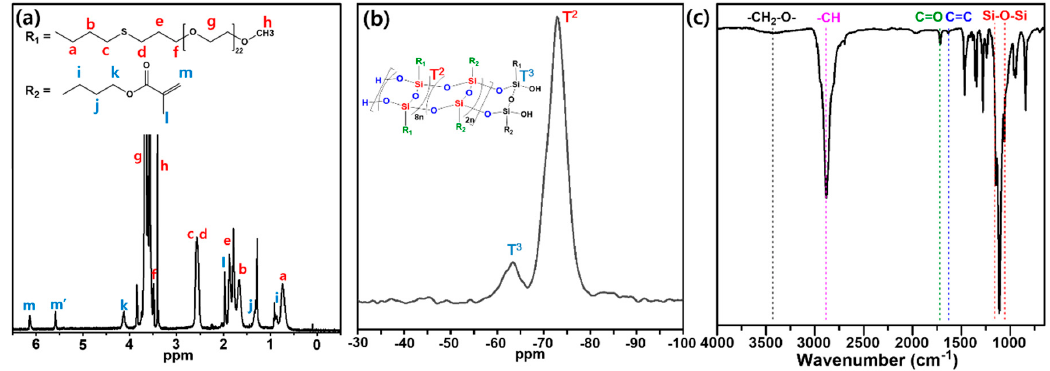
Figure 2. ( a ) 1 H NMR, ( b ) 29 Si NMR, and ( c ) FTIR spectrum of LPEGMASQ82.